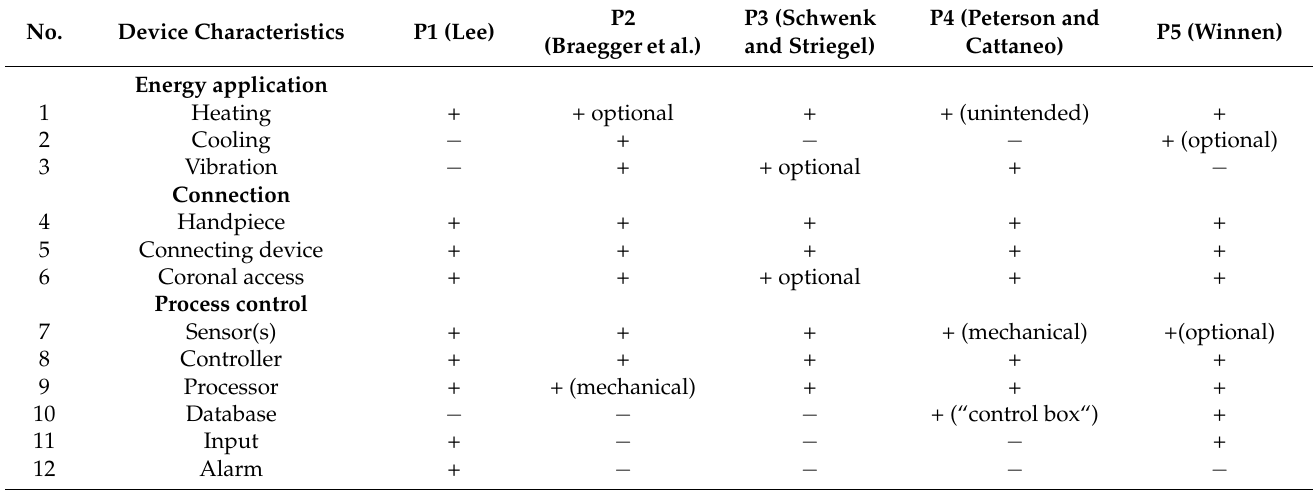
Table 1. Comparison of the